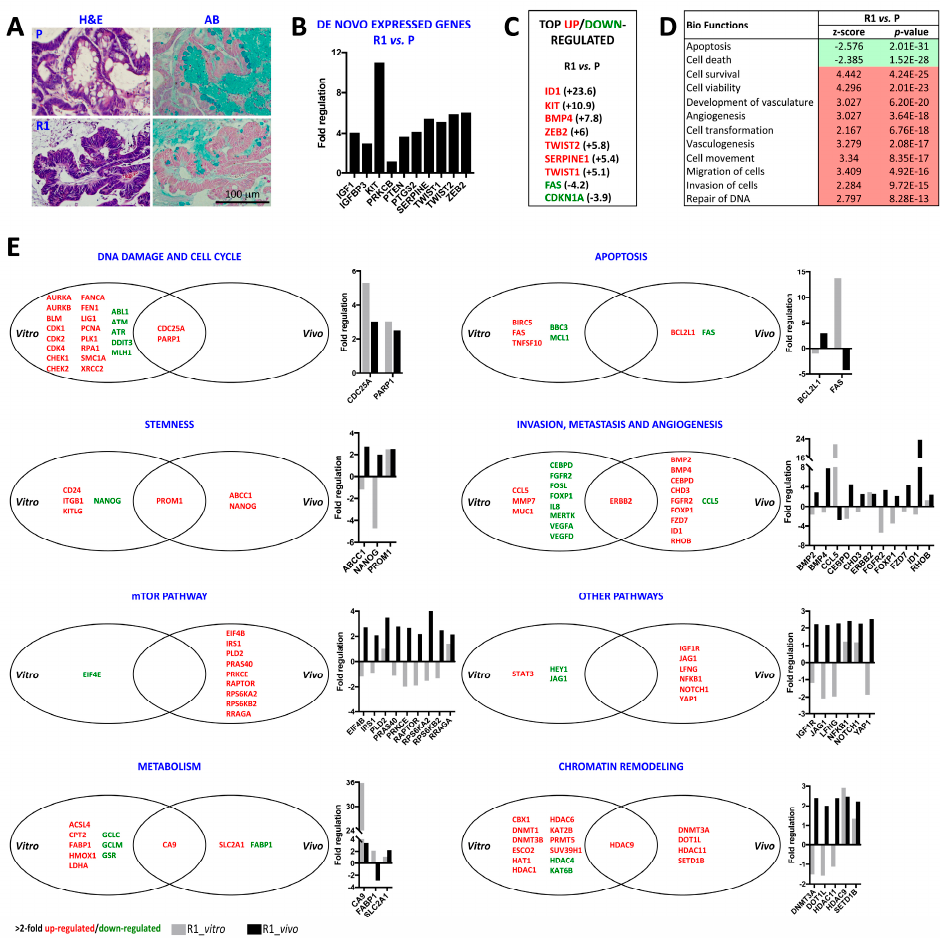
Figure 4. Differential histology, gene expression profiles and biological functions in R1 cells versus parental cells in vitro and in vivo. ( A ) PFA-fixed, paraffin-embedded serial sections of parental or R1 cell-derived tumor xenografts stained with hematoxylin and eosin (H&E) or alcian blue (AB). Characteristics of R1 cell-derived tumor xenograft include: a pseudostratified glandular epithelium with marked nuclear atypia and cellular overlapping and few mucinous goblet cells. Parental cell-derived tumor xenograft shows a lesser degree of architectural abnormalities including glands with low-grade cytologic dysplasia and abundant goblet cells. Pictures are representative of five histological sections/tumor. ( B ) Graph shows fold regulation (positive fold changes) of de novo expressed genes in R1 cell- versus parental cell-derived tumor xenograft. ( C ) List of the top up- or downregulated genes in R1 cell- versus parental cell-derived tumor xenograft obtained by real-time PCR arrays. ( D ) Biological functions ranked by p -value (from smallest or strongest to largest or weakest) predicted by IPA to be activated (red) or inhibited (green) in R1 cell- versus parental cell-derived tumor xenograft. ( E ) Venn diagrams show the lists of diverging and overlapping genes (for each of the following categories: DNA damage and cell cycle; apoptosis; stemness; invasion, metastasis and angiogenesis; mTOR pathway; other pathways; metabolism and chromatin remodeling) whose expression was altered ( ≥ 2.0 or ≤− 2.0) in R1 cells as compared to parental cells in vitro and in vivo. Upregulated genes are in red, downregulated genes are in green. Graphs on the right of each Venn diagram show differential regulation of selected genes in vitro (grey bars) and in vivo (black bars).